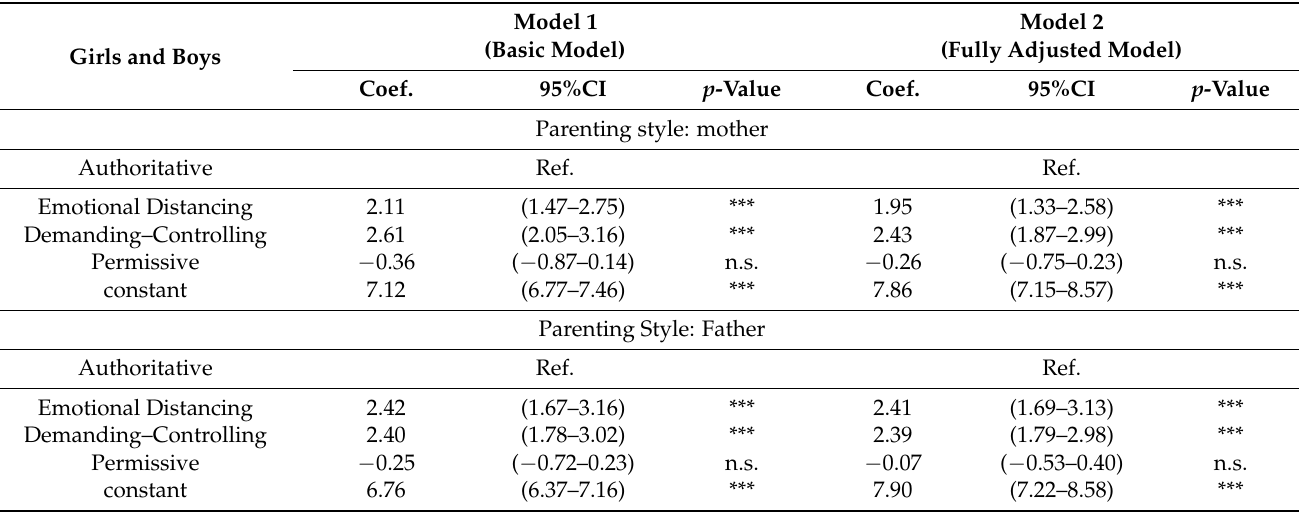
Table 5. Multiple linear regression results for associations between Strengths and Difficulties Questionnaire total difficulties score and mother’s and father’s parenting style, adjusted for control variables (Model 1) and mediator variables (Model 2).